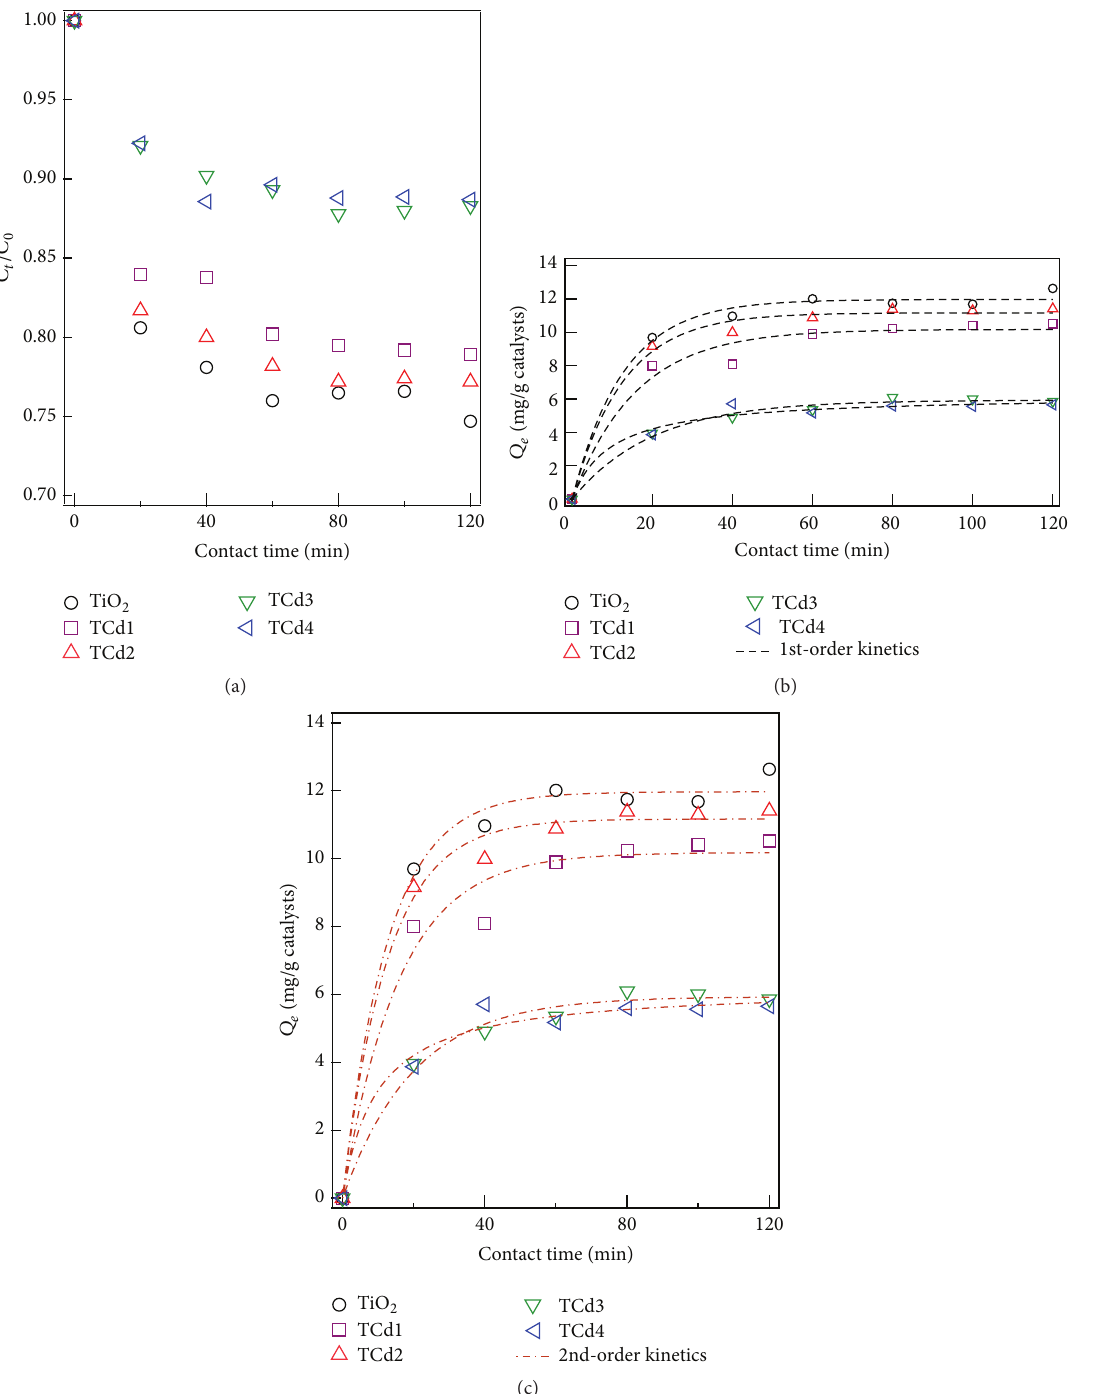
Figure 8: (a) Effect of contact time on the residual concentration of MB over the different adsorbents. Nonlinear fits of (b) pseudo-first- order and (c) pseudo-second-order kinetic models to the sorption time data for the various adsorbents at 𝐶 0 = 100mg/L, pH = 7.44, and 𝑇 = (300.0 ± 0.3)